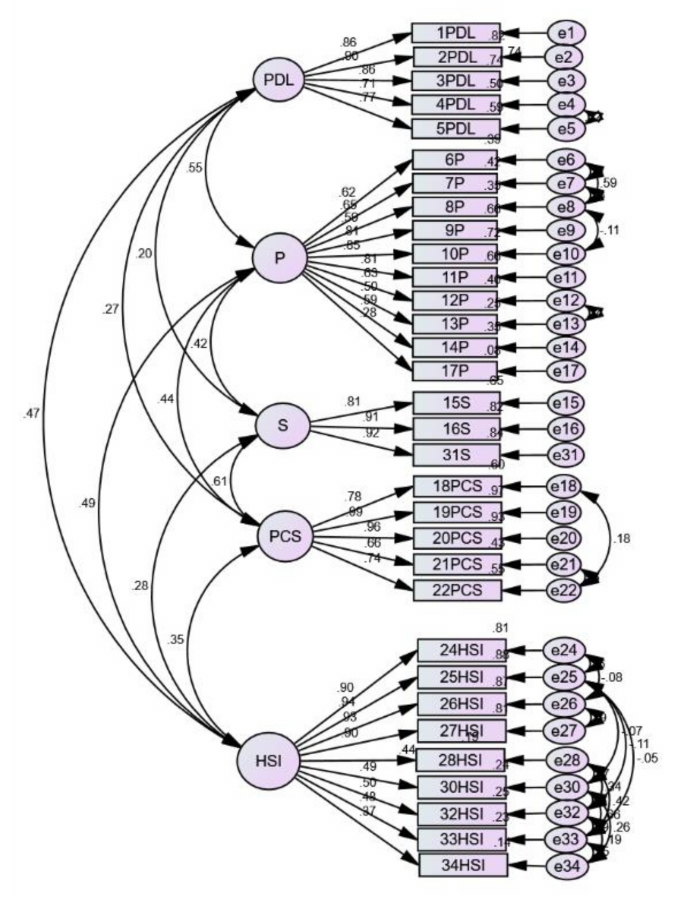
Figure 1. Results of structural equation model analysis for the short-form Supportive Care Need Survey Malay version (SCNS-SF34M). Physical and daily living needs (PDL), psychological needs (P), sexuality needs (S), patient care and support needs (PCS) and health systems and information needs